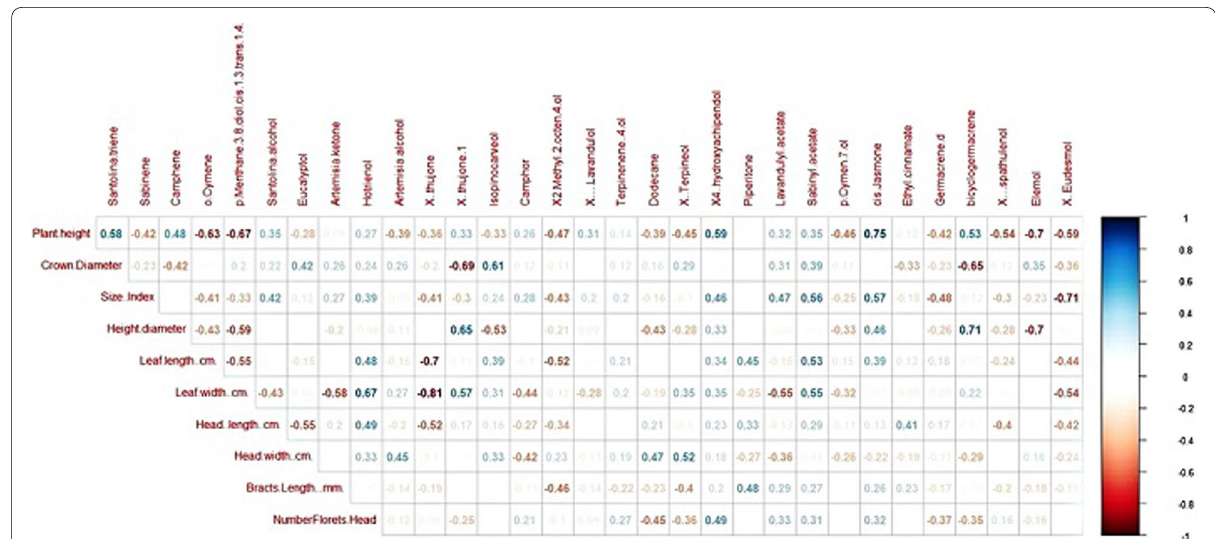
Fig. 8 The correlation coefficients between the chemical components of the essential oils and the ten morphological traits for the 12 accessions of A. fragrantissima as two variables calculated by